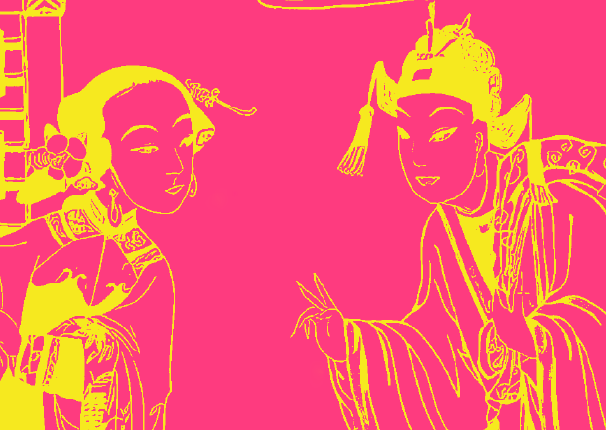
Figure 14. This is a figure. Schemes follow the same formatting.